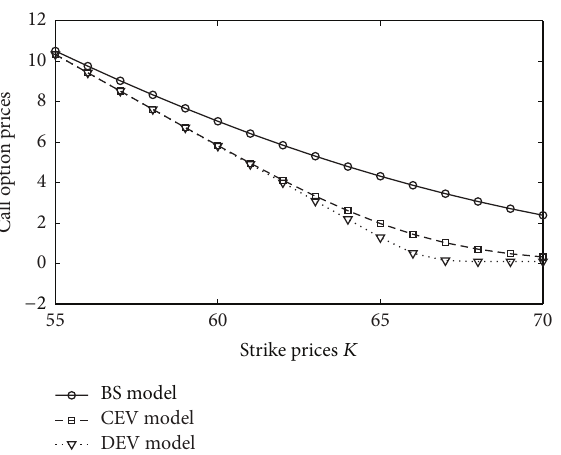
Figure 10: Call option prices at 𝑆 0 = 65 during “9/11” event.